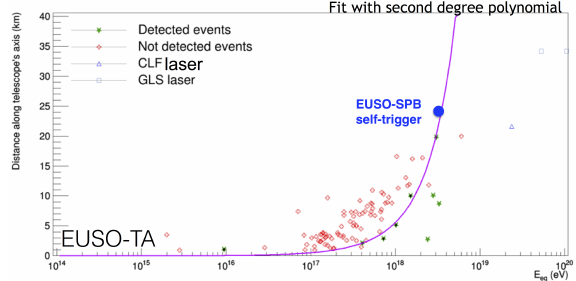
Figure 3. All UHECRs detected by TAFD in the EUSO-TA FoV during its operation with non-detected events and laser shots su- perimposed. The vertical axis shows the distance to the shower axis. The horizontal axis shows the events equivalent energy. The fit to the detected points suggests an estimate of EUSO-TA de- tection energy threshold. The blue point indicates the estimated energy threshold of EUSO-SPB determined during the field